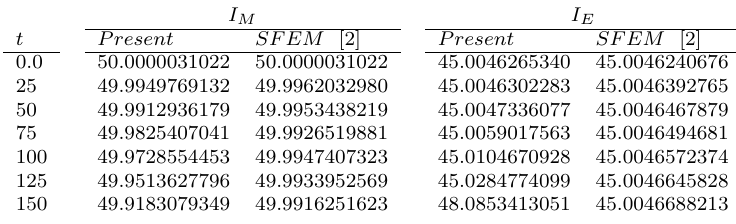
Comparison of conserved quantities for undular bore initial condition with a = b = c = 1, d = 0 . 5, v = 1 . 18 and h = ∆t = 0 . 1.